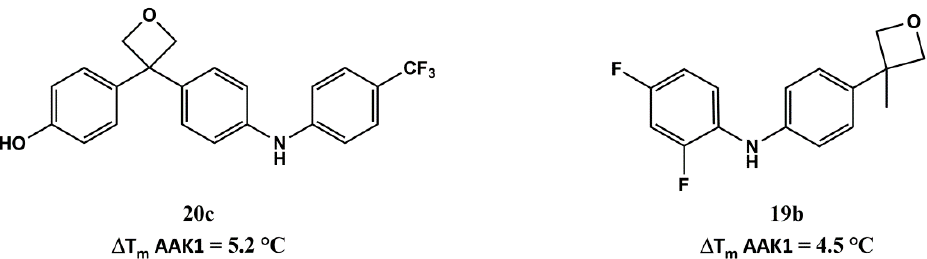
Figure 7. ∆ Tm values obtained for the AAK1 AP2-associated protein kinase 1.